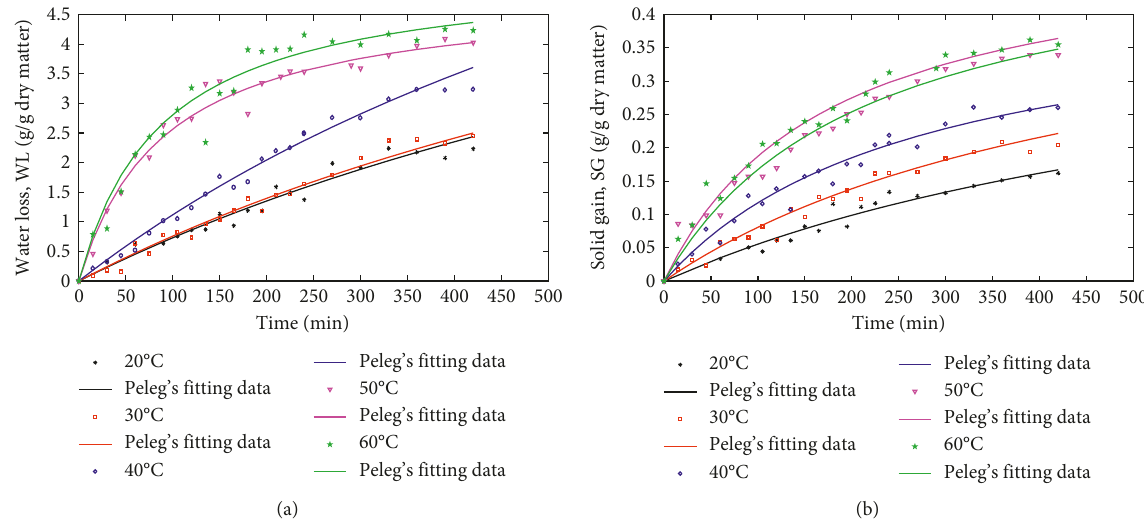
Figure 3: Effect of temperature on mass transfer during the OD of pomegranate seeds: (a) water loss and (b) solid gain ( C 330rpm, and sample/solution weight ratio